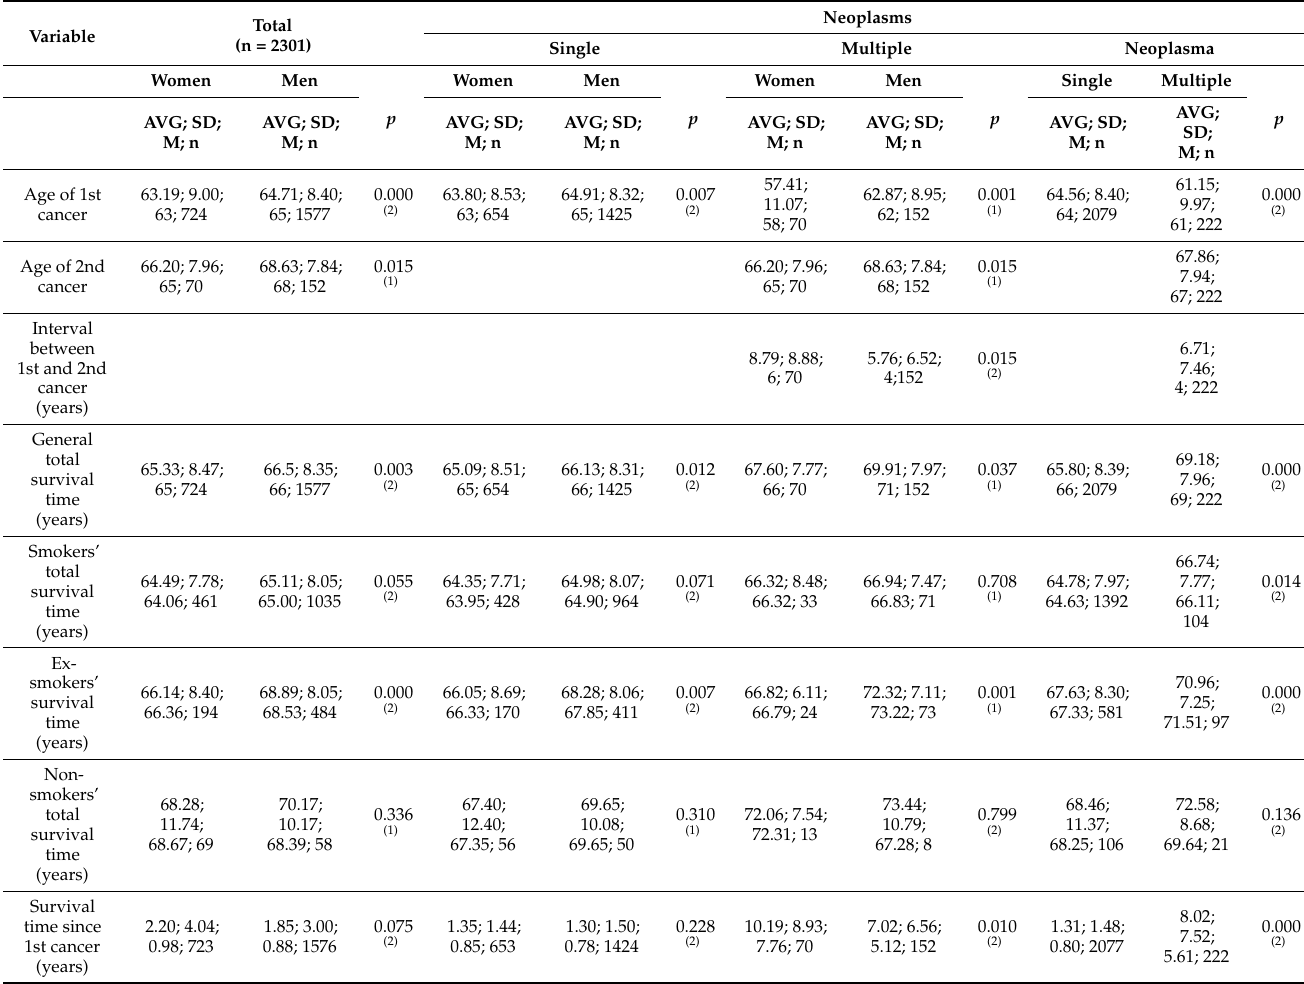
Table 2. Morbidity and survival time with consideration of tobacco